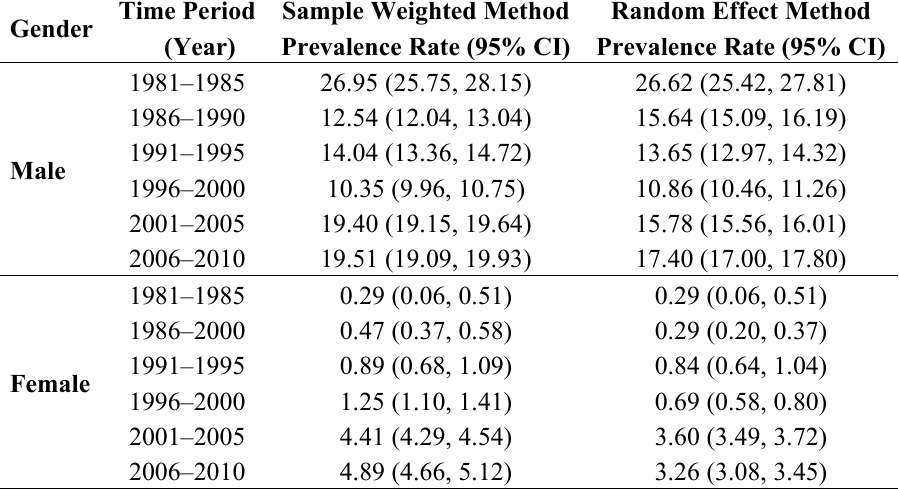
Table 2. Comparison of the estimated prevalence rates (95% CI) of current smoking among adolescents in China using two different